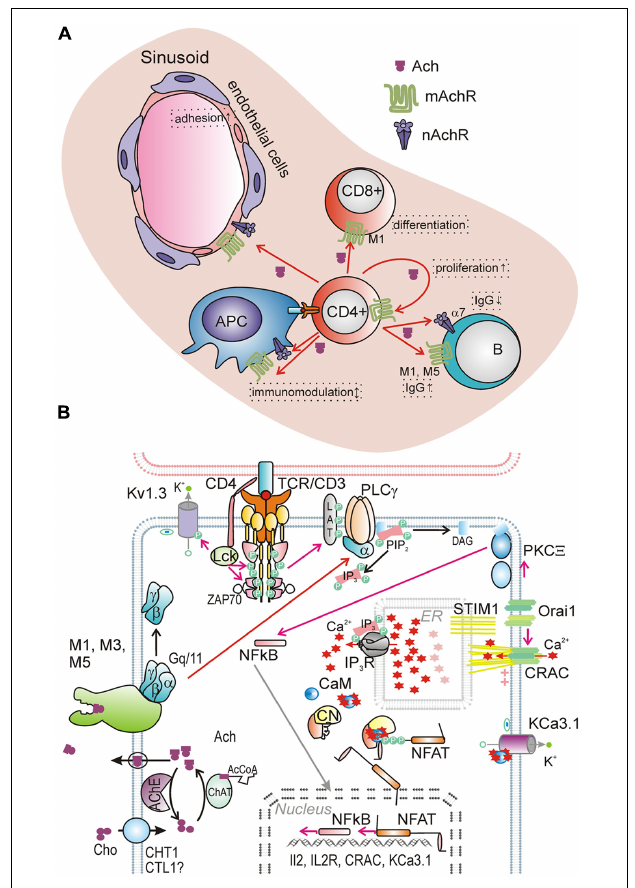
FIGURE 1 | Current view on T cell NNCS in regulation of immune function. (A) Proposed paracrine and autocrine effect of T cell-derived ACh in T cell microenvironment. (B) Role of NNCS in Ca 2 + signaling and gene expression in healthy T-lymphocyte. (A) TCR- and muscarinic (M1, 3, 5) receptor- triggered signaling pathways are cross-linked in T cells. In healthy T-cells, principle route of phospholipase C (PLC γ ) activation upon recognition of antigen-presenting cell occurs via TCR/CD3 complex. TCR –generated signal is amplified by a co-receptor (CD4), which recruits Lck, a